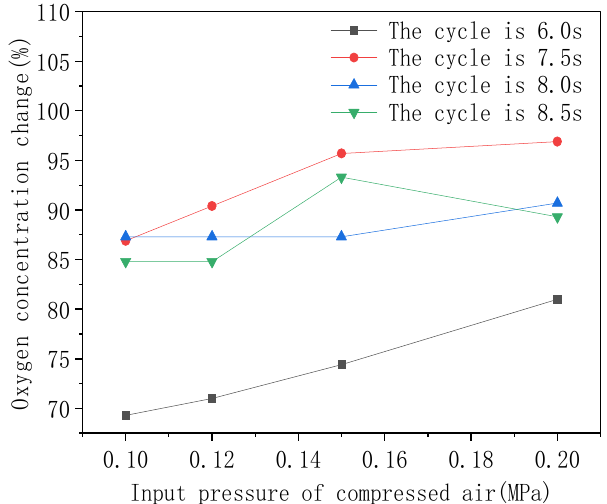
Figure 6. Cycle data of oxygen-generation system.